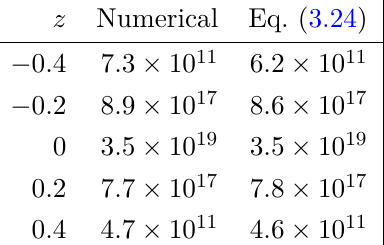
(parameterized k